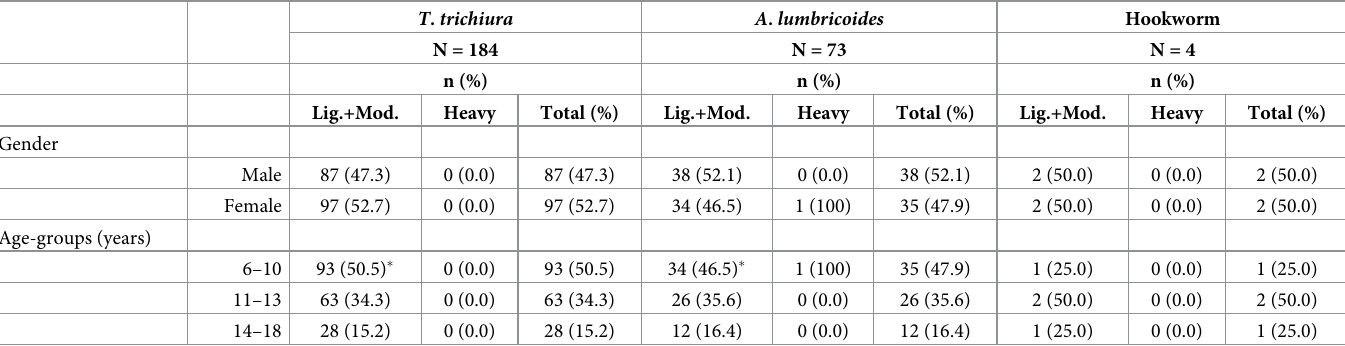
Table 4. STH intensity of